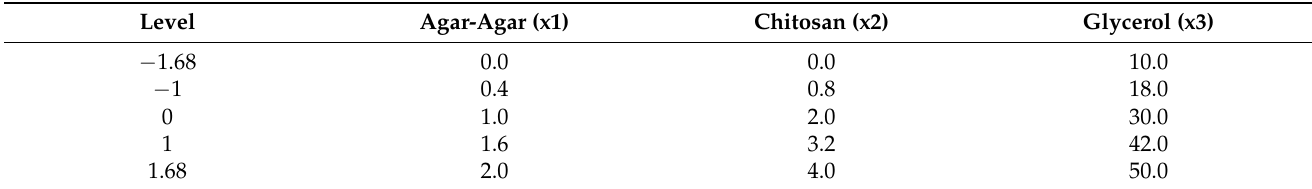
Table 1. Real and coded values of experimental design